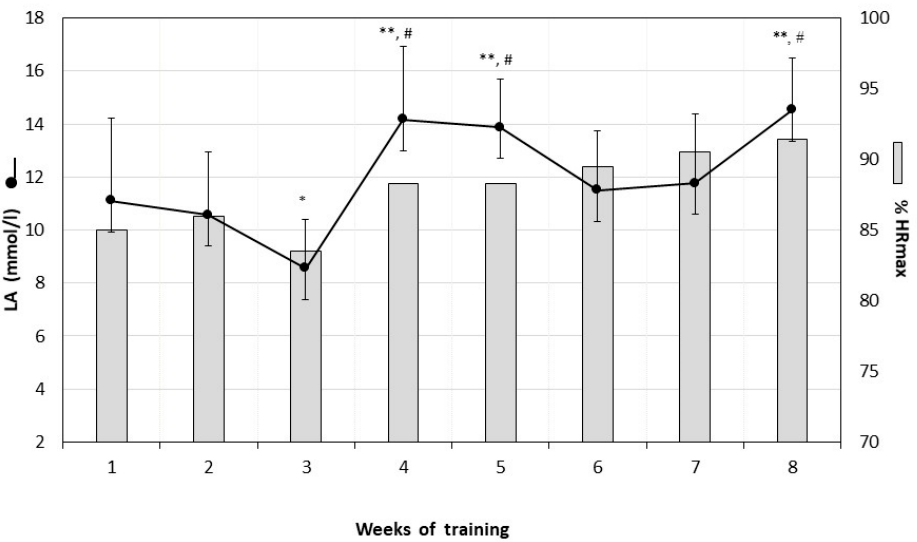
Figure 3. Mean lactate level after two training sessions in each training week and mean % HR max of the two training sessions in each training week. * p < 0.05 in comparison to lactate after the first; second; sixth; seventh training weeks; ** p < 0.005 in comparison to the third week; # p < 0.01 in comparison to the first; second; sixth and seventh weeks of training (Student’s t-test for dependent values). LA = lactate, HR = heart rate.